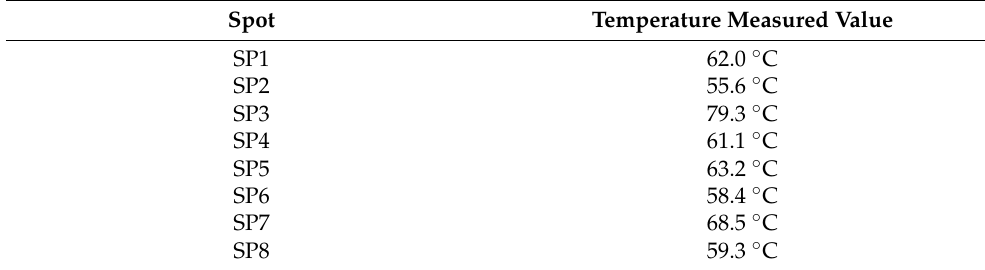
For a healthy PV panel, thermal scanning indicates the minimum working temperature of 58.6 ◦ C and the maximum temperature of 60.9 ◦ C. The highest temperature values in Table 2 (i.e., SP3 of 79.3 ◦ C, SP5 of 63.2 ◦ C, SP7 of 68.5 ◦ C) confirm the hot spots on the 3 faulty panels (i.e., a total of 8